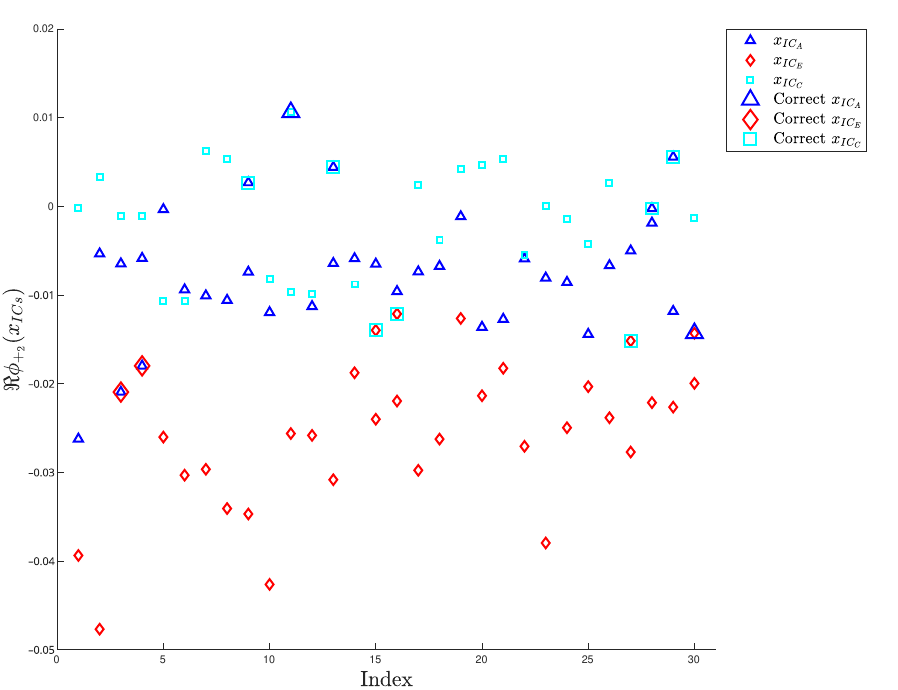
Figure 5. Classification of the initial conditions according to the evaluation of the eigenfunctions on the saddle